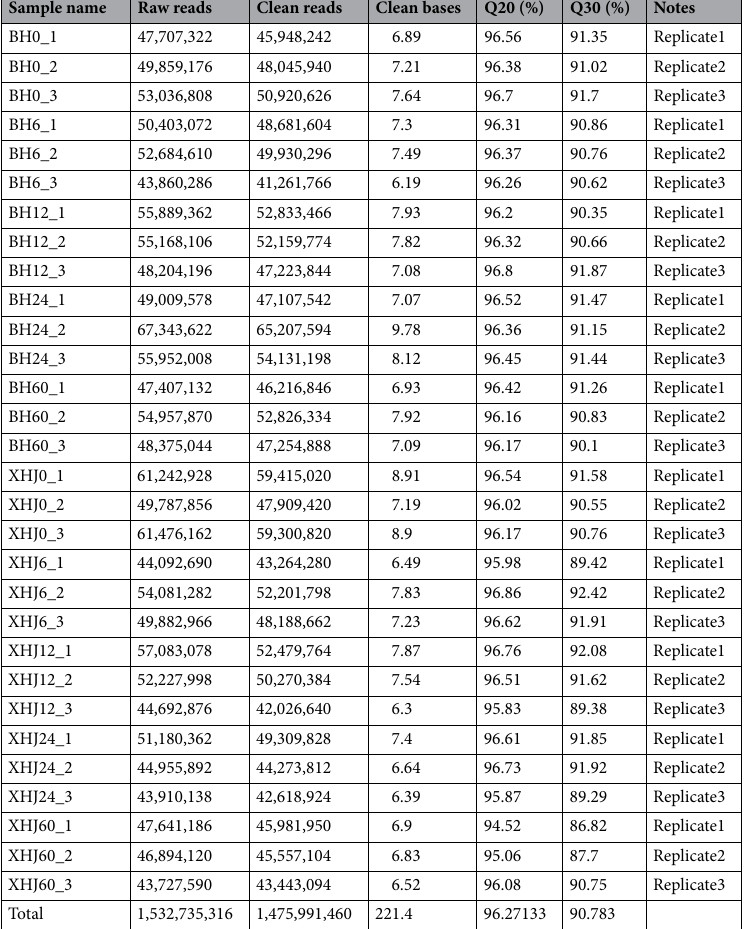
Table 1. Statistics from Illumina